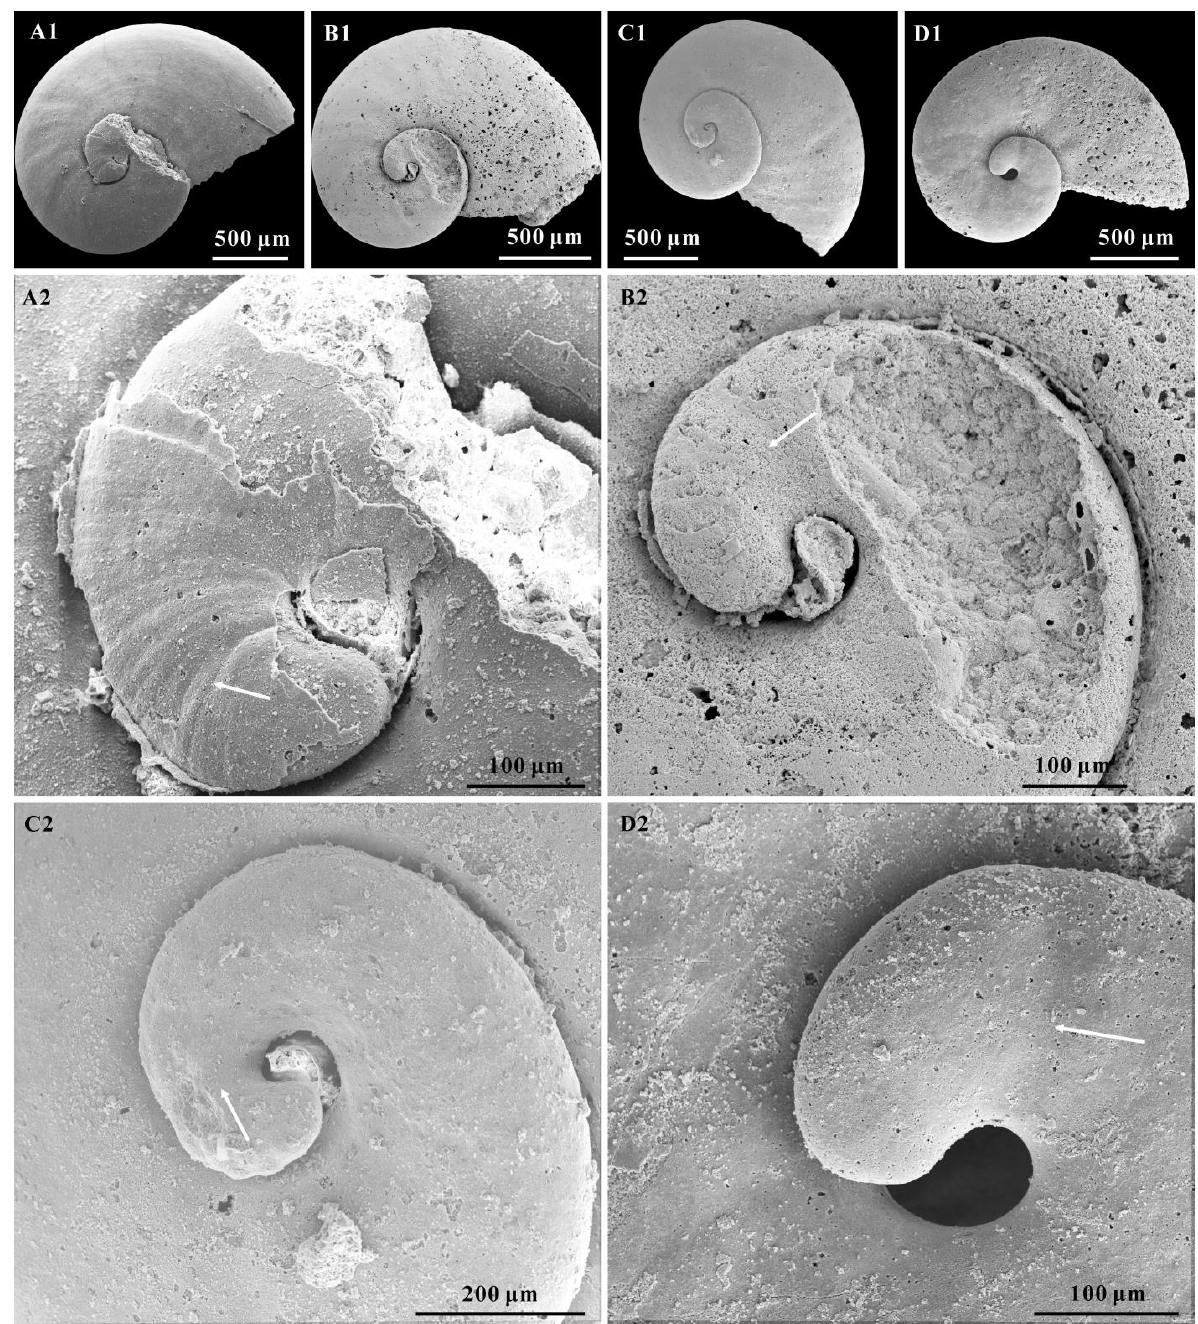
Figure 5. The protoconch of Aldanella attleborensis . ( A ), internal molds with external coating, apical views, CUBar79-26; ( A2 ) magnification of ( A1 ) showing the absence of growth lines on the protoconch. ( B ), internal molds, apical views, CUBar206-5; ( B2 ) magnifications of ( B1 ) showing the slight groove between the protoconch and teleoconch. ( C ), internal molds, apical views, CUBar14-12; ( C2 ) magnifications of ( C1 ) showing the slight groove between the protoconch and teleoconch. ( D ), internal molds, apical views, CUBar115-3; ( D2 ) magnifications of ( D1 ) showing the slight groove between the protoconch and teleoconch. White arrows indicate the position that distinguishes protoconch and teleoconch. Specimens from Yanjiahe